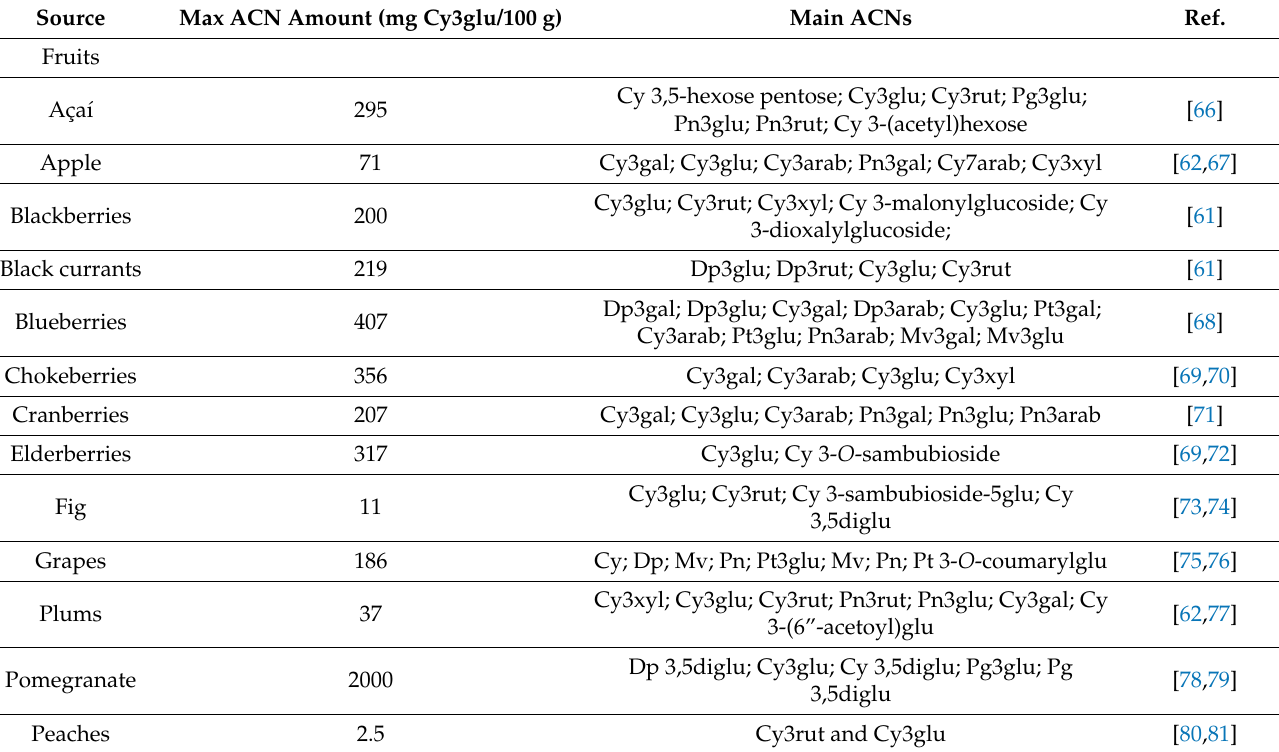
Table 1. Concentration of ACNs in fruits and vegetables (fresh weight;